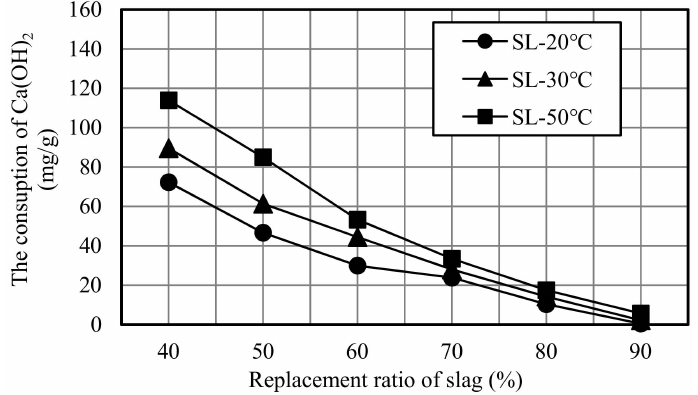
Figure 6. Ca(OH) 2 consumption of di ff erent slag